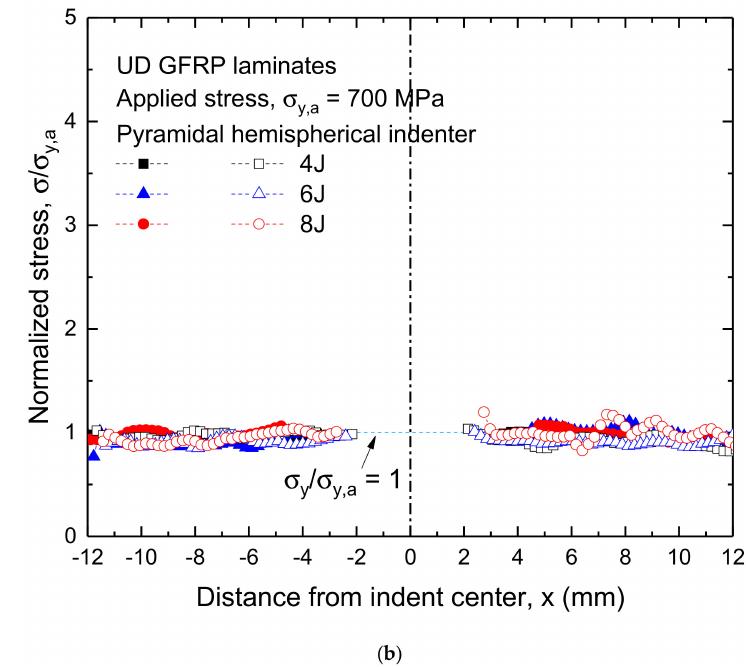
Figure 11. Normalized longitudinal stresses ahead of the indent for the impacted ( a ) TRI and ( b ) UD GFRP